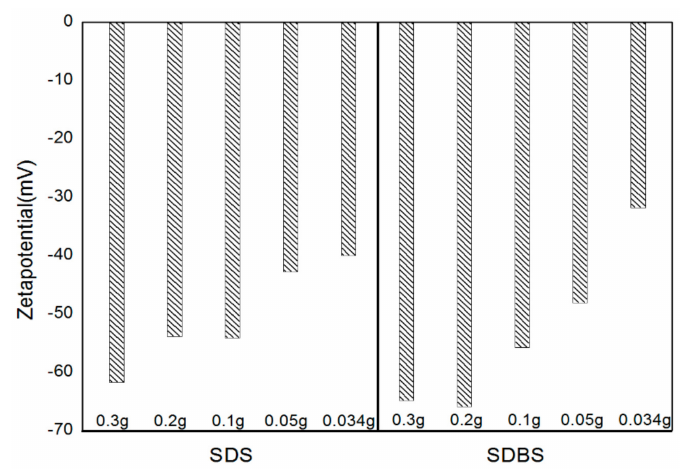
Figure 3. Zeta potential of graphene by various conditions.